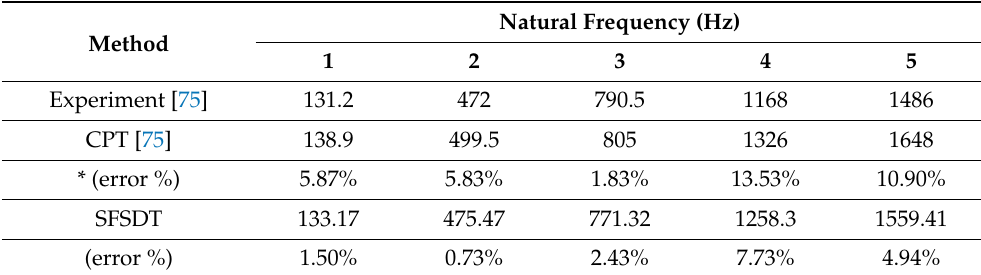
Table 5. Natural frequencies of graphite/epoxy [45, − 45 2 , 45] s square cantilever plate ( a = 76.2 mm, a / h = 73.2).